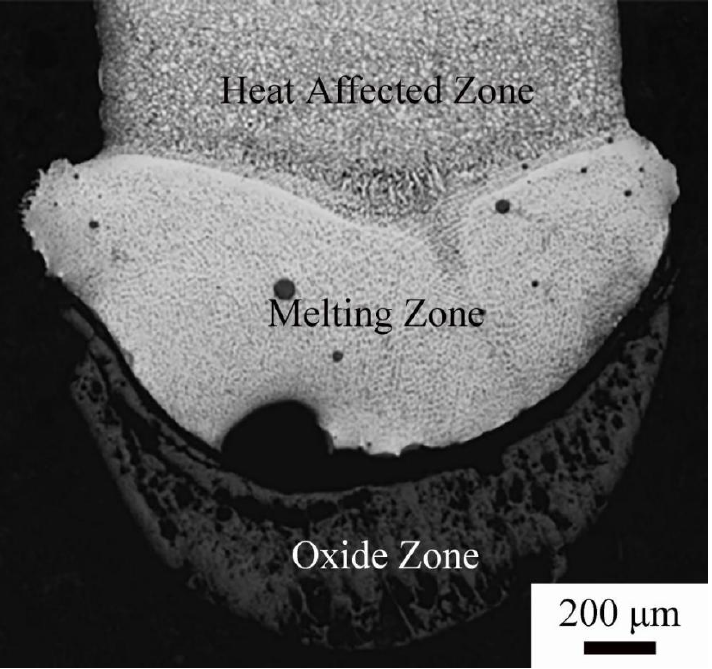
Figure 7. SEM photographs of combustion area of a nickel alloy, reproduced from [57] with permission from ASTM, 2020.